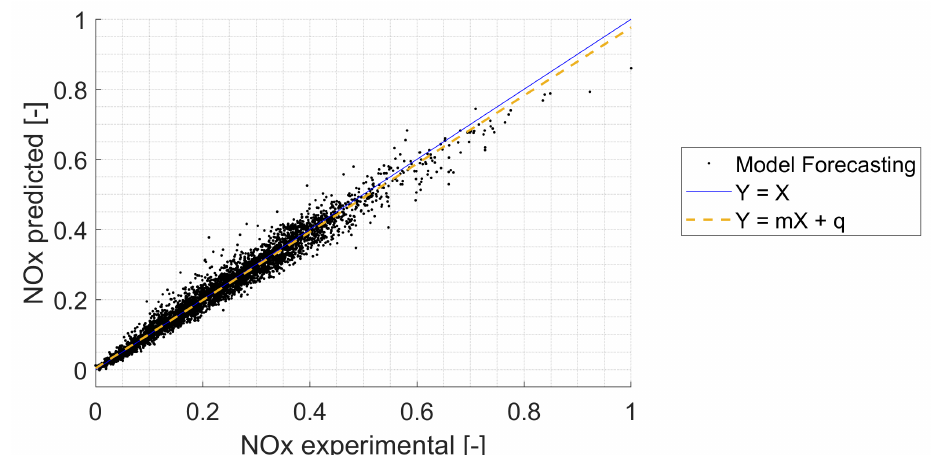
Figure 6. Regression prediction results of training conducted on bench test conditions and test carried out under ECU test conditions.